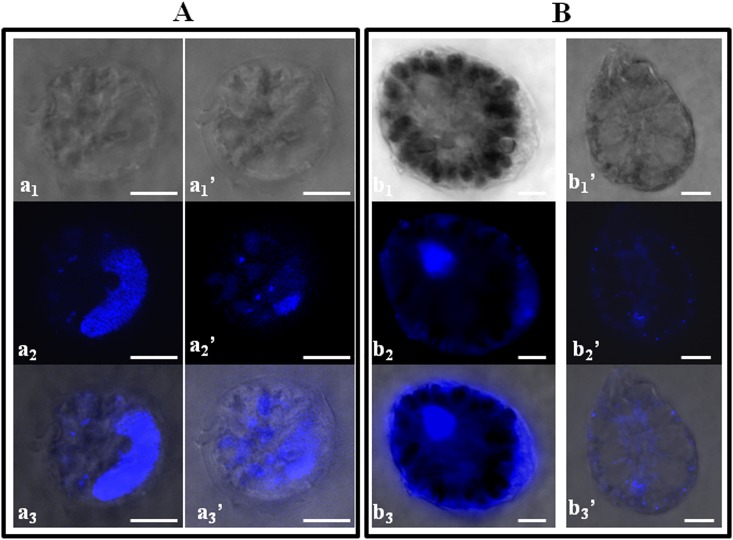
Light (a1,a1’,b1,b1’), epifluorescence (a2,a2’,b2,b2’) and superposed light-epifluorescence (a3,a3’,b3,b3’) microscope photographs of dinoflagellate vegetative cells cultured with Ulva rigida thalli.A: Alexandrium pacificum cells (a1-a2-a3 = control, a1’-a2’-a3’ = cell exposed to 0.16g (FW) of Ulva rigida after 3 days of co-culture). B: Ostreopsis cf. ovata cells (b1-b2-b3 = control; b1’-b2’-b3’ = cell exposed to 1g FW of Ulva rigida after 10 days of co-culture). Scale bars, 10 μm.